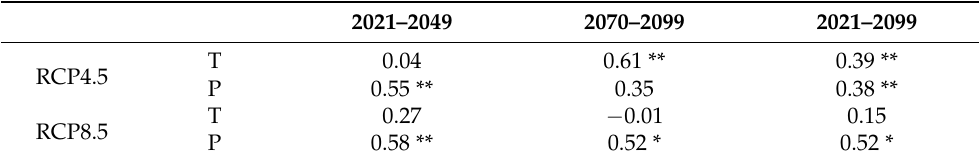
Table 2. The coefficients of detrended temperature and precipitation anomalies with IAV NPP under the RCP4.5 and RCP8.5 scenarios in the different periods of 21st century. Statistically significant correlations are marked with ** ( p < 0.01) and * ( p <